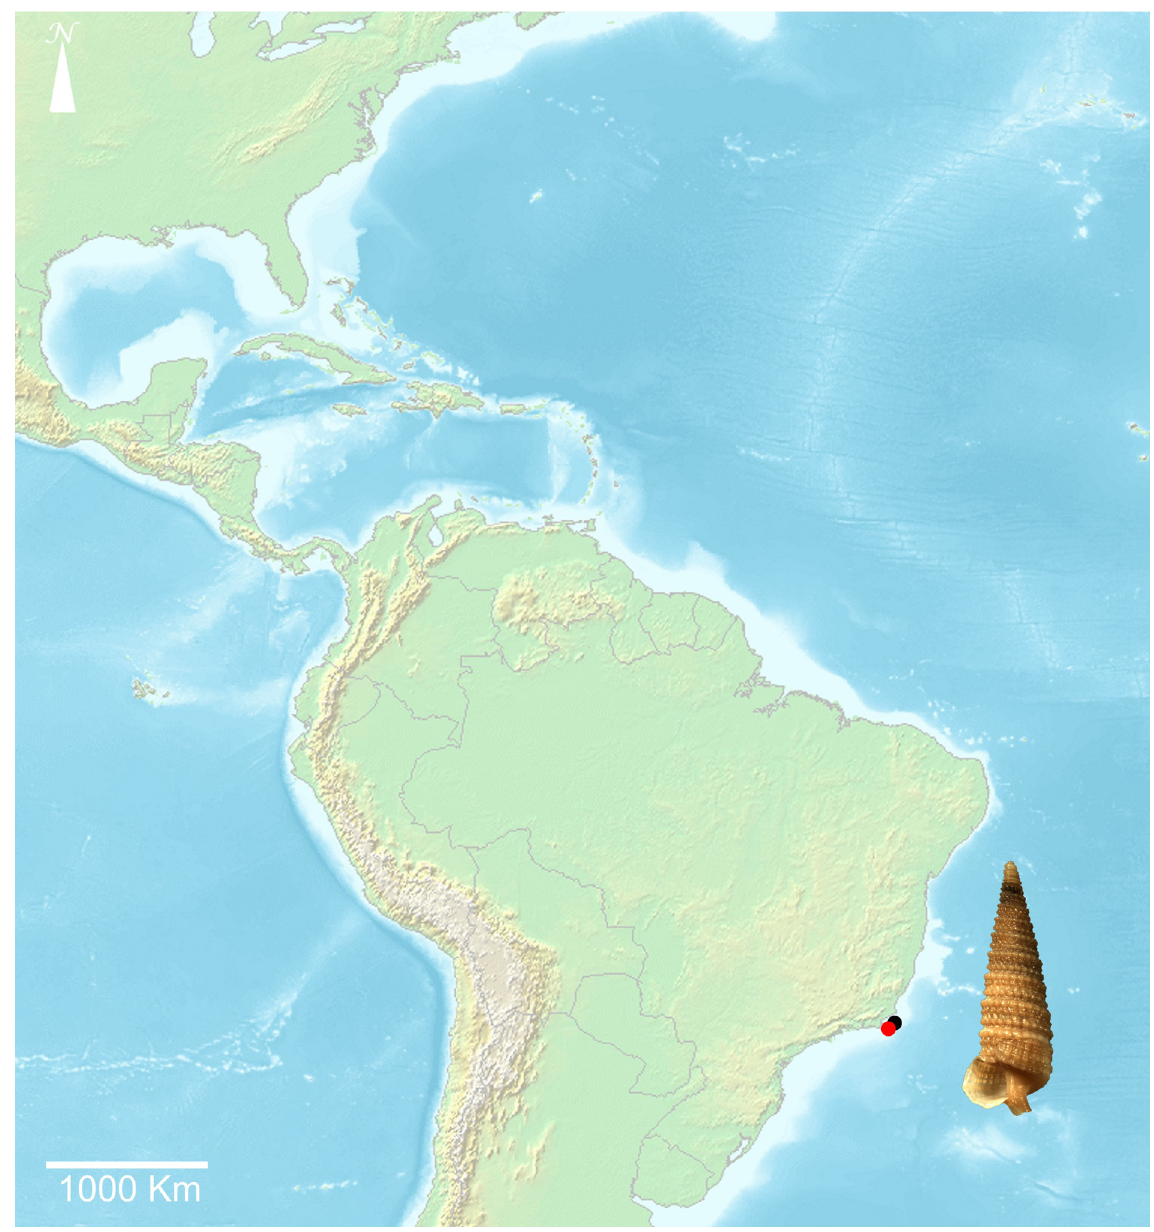
Fig. 40. Distribution map of “ Inella ” galo Fernandes & Pimenta, 2019; red circle = type